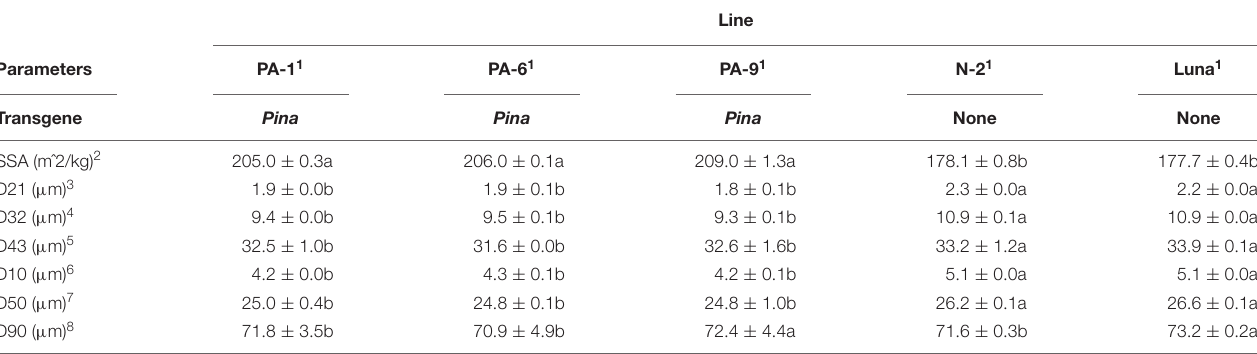
TABLE 2 | Flour particle diameters of the transgenic and control